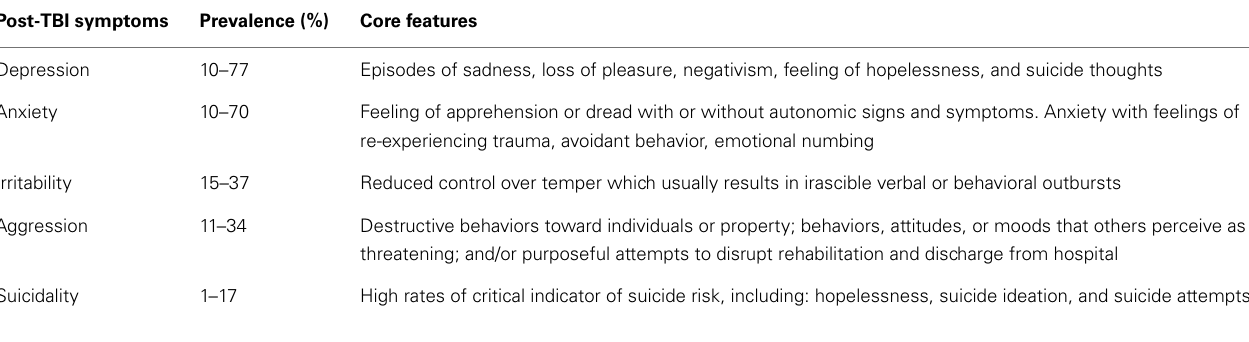
Table 1 |Traumatic brain injury-related neuropsychiatric